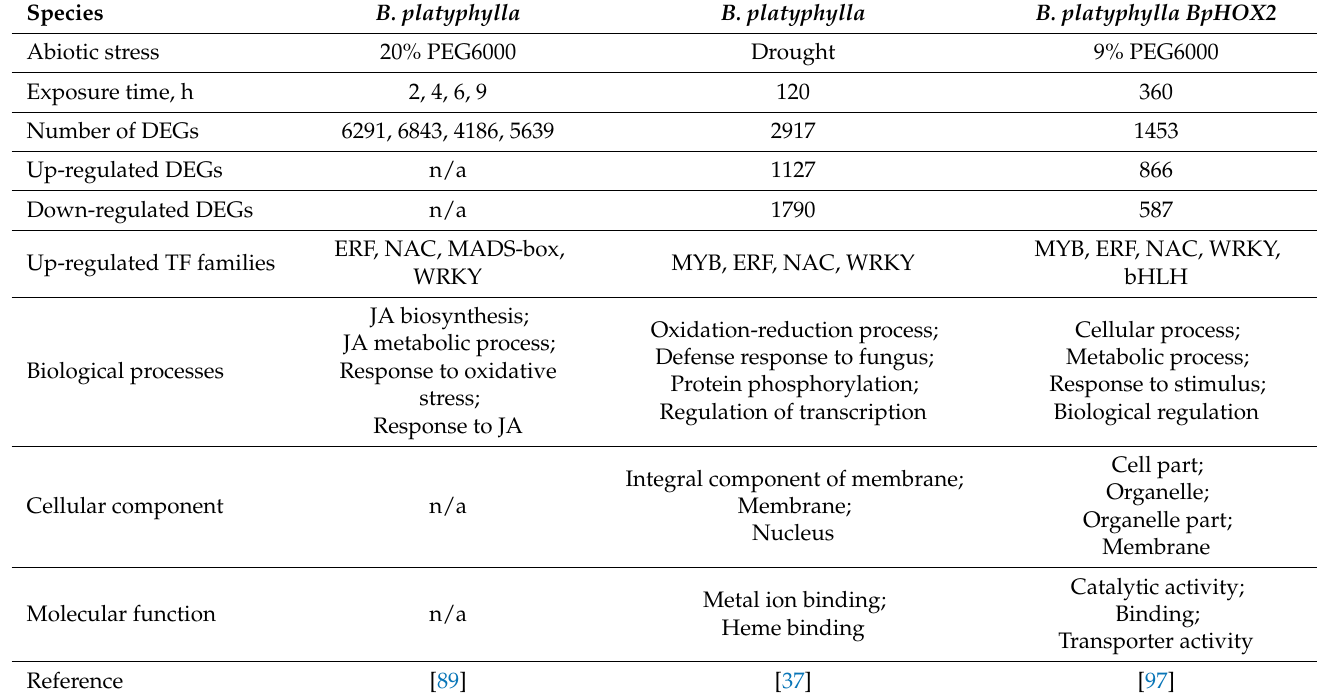
Table 2. Initial conditions and main results of differential expression analysis in the three-month-old seedlings of B. platyphylla under drought and PEG-mediated osmotic stress. Species B. platyphylla B.